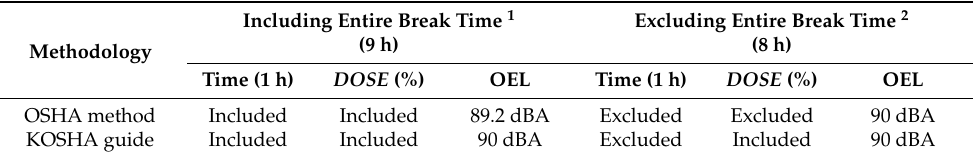
Table 2. Comparison of noise exposure assessment methods between the U.S. OSHA method and KOSHA